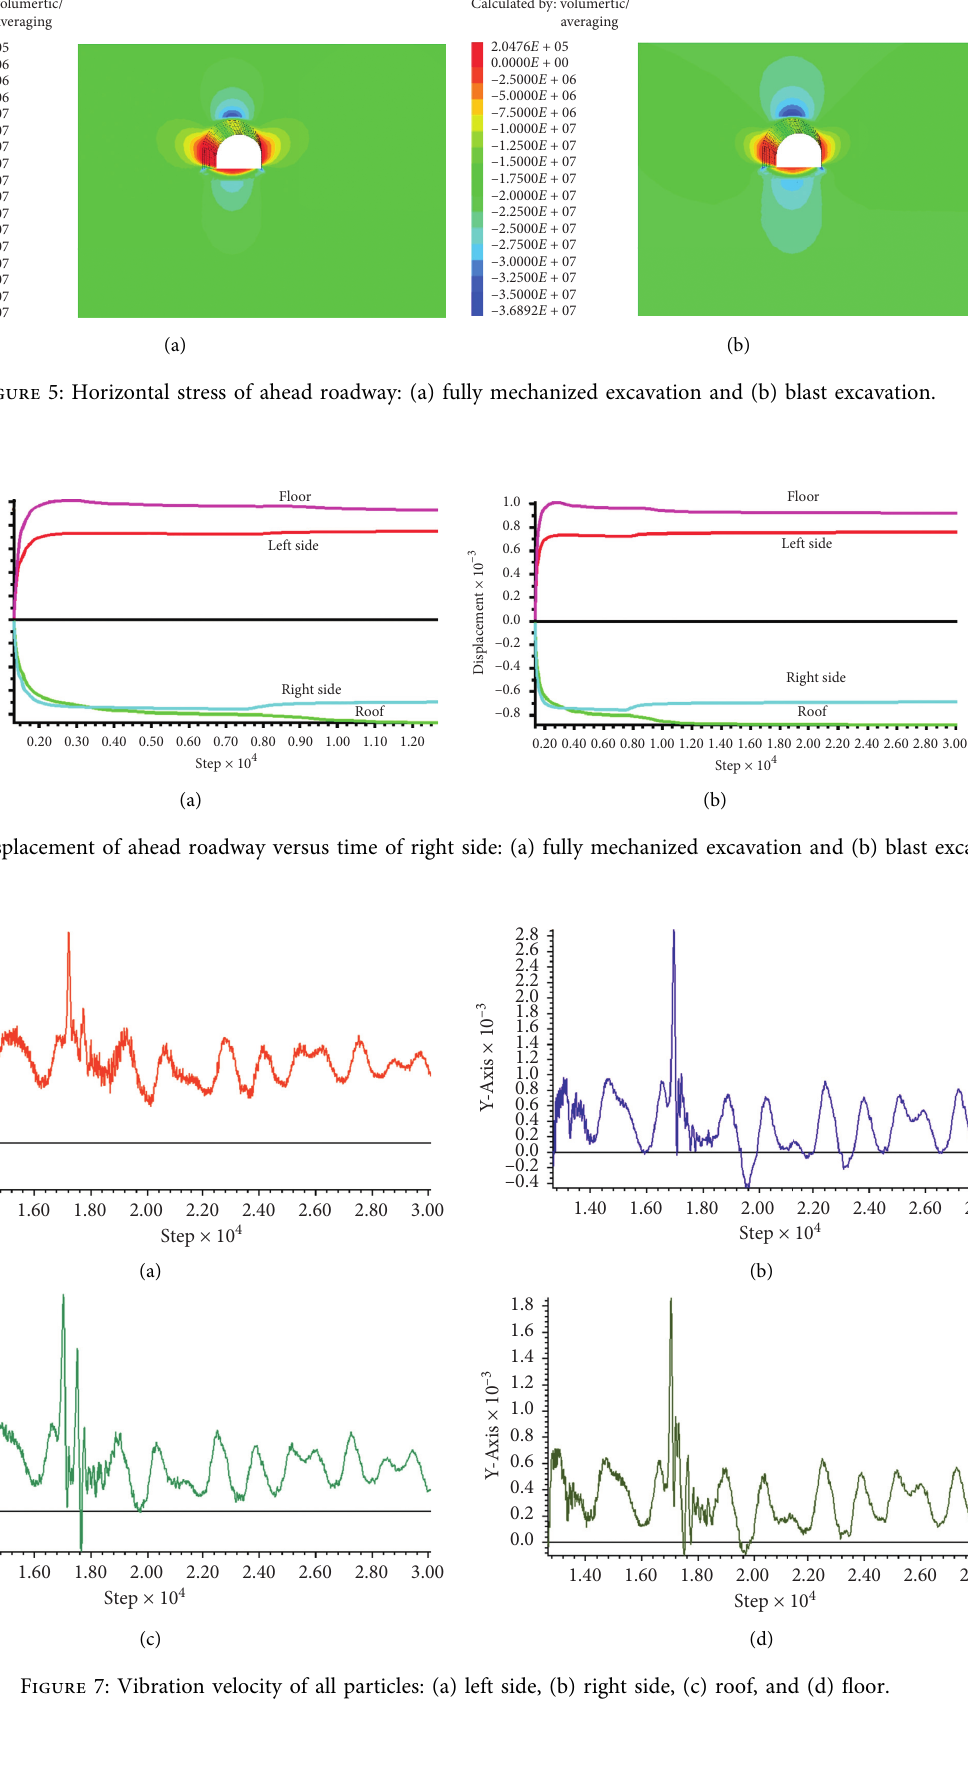
Figure 7: Vibration velocity of all particles: (a) left side, (b) right side, (c) roof, and (d)